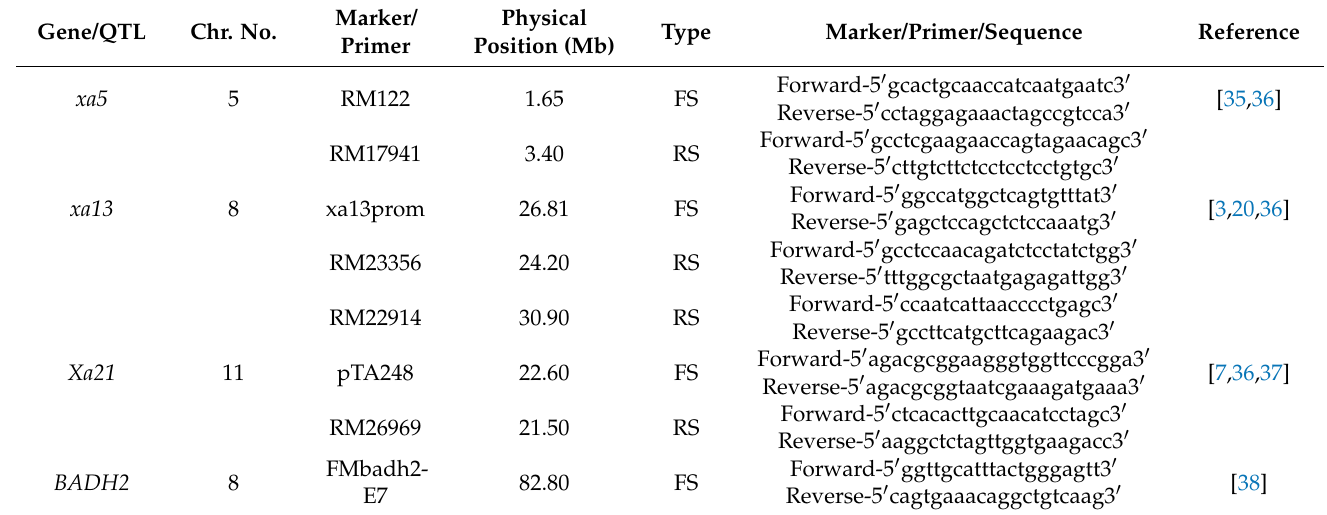
Table 2. Gene specific/linked SSR markers used for introgression of the corresponding gene in HUR 917 background.